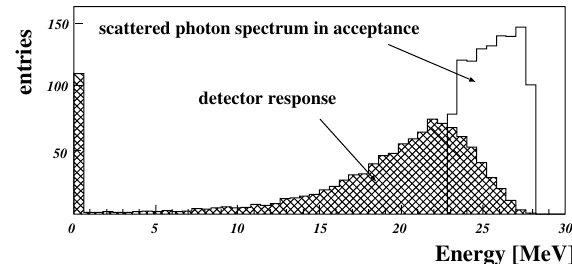
FIG. 2. Expected energy spectrum. The solid histogram shows the scattered photon energy spectrum passing through the collimator while the hatched histogram represents the spectrum smeared by detector